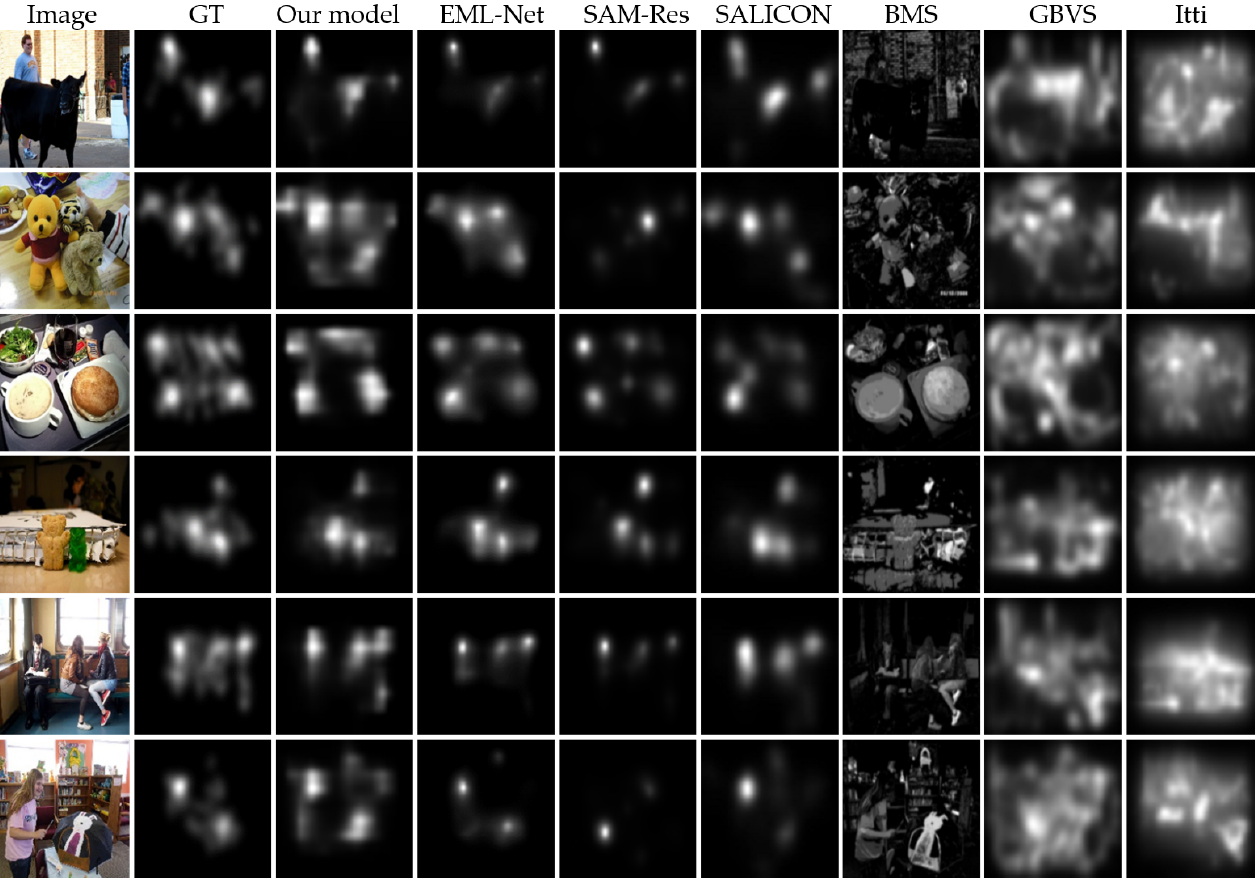
Figure 3. Saliency maps of various models on the SALICION validation dataset.